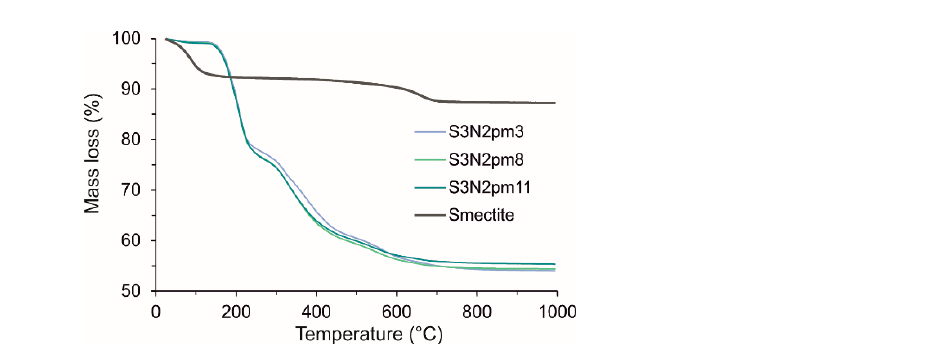
Figure 5. TG patterns of smectite–urea composites compared with smectite. The weight losses of the intercalated nitrogen in intervals of 300–450 °C and 450–590 °C. Table 1. The weight losses (%) of smectite–urea composites according to TG curves.